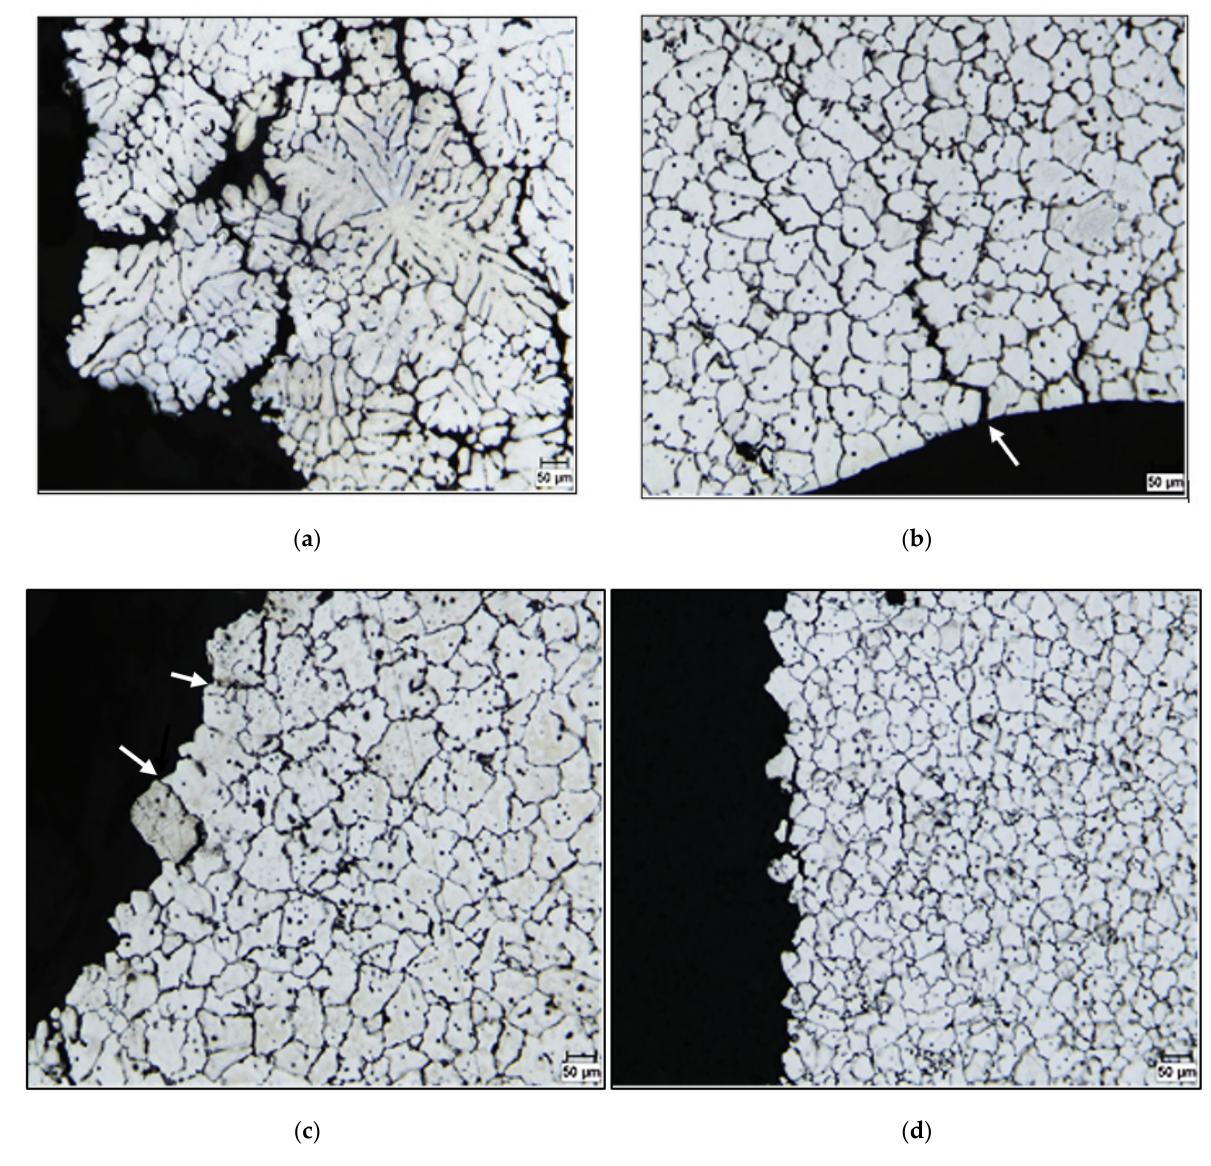
Figure 13. Grain structures obtained for various alloys in the Zr-Ti group: ( a ) base alloy, ( b ) G alloy, ( c ) G1Z alloy, and ( d ) G3Z alloy. Note the fine cracks in ( c )—white arrows.